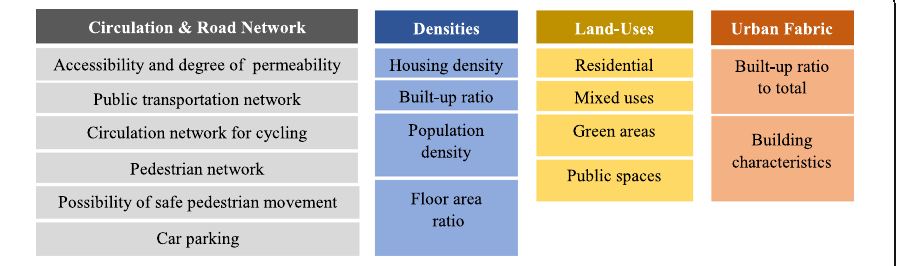
Fig. 2 Key elements of the city urban form. Source: Author, based on [12, 14, 22,